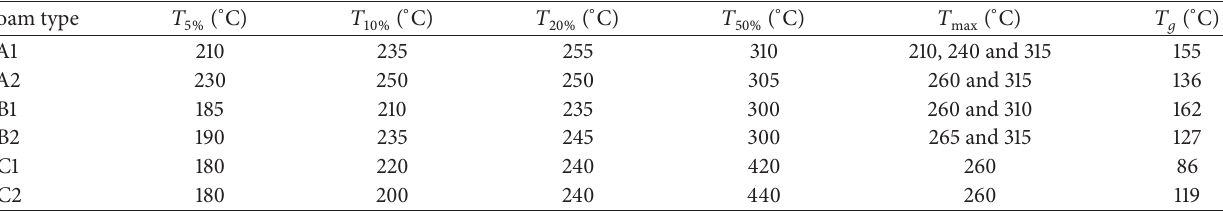
Table 6: Polyurethane foams thermal stability.